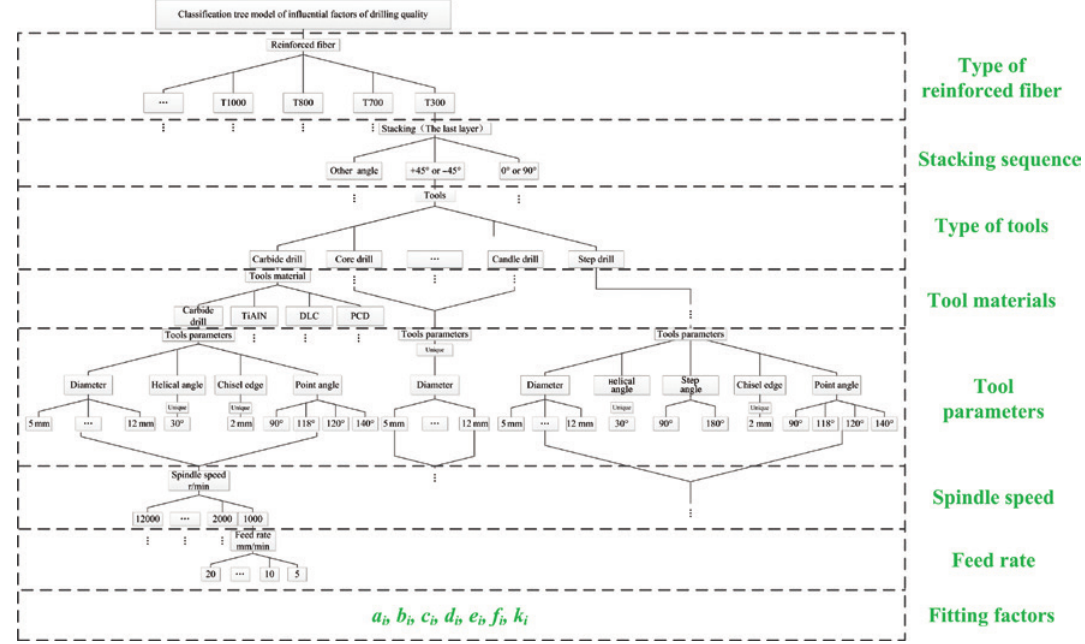
Figure 1: Classification tree model of influential factors of drilling